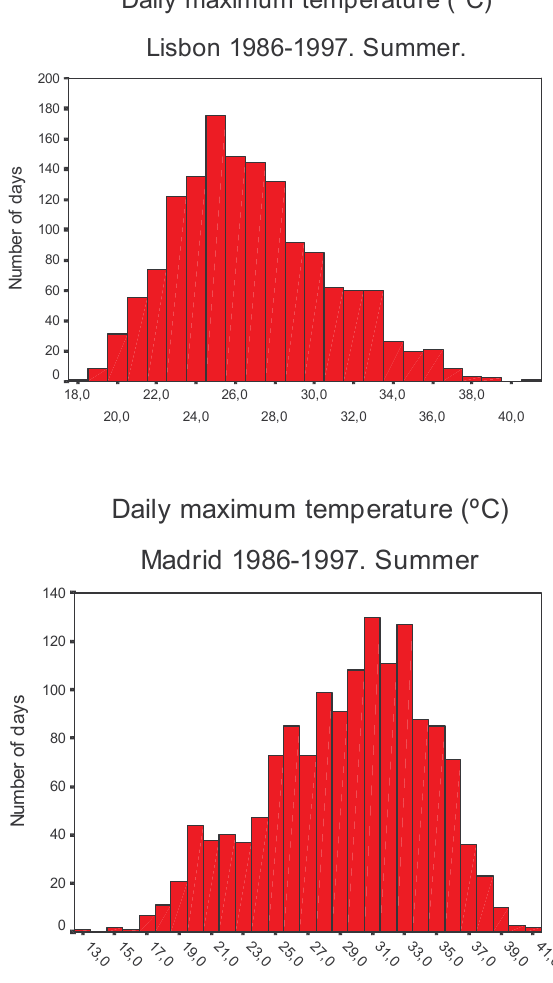
Fig. 2. Histograms of summer (JJAS) T max for Lisbon (upper pan- nel) and Madrid (lower pannel) for the short 1986–1997